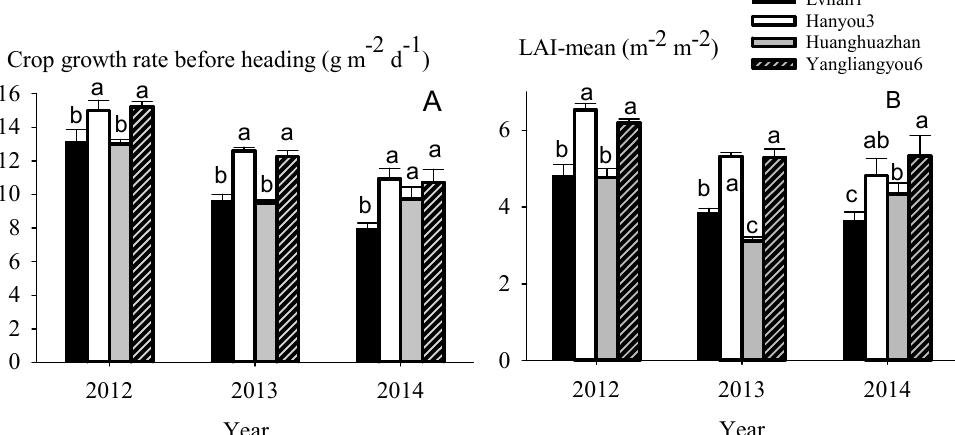
Figure 3. Crop growth rate (CGR) from sowing to heading ( A ) and mean leaf area index (LAI) from panicle initiation to heading ( B ). Lvhan1 (inbred) and Hanyou3 (hybrid) are typical upland rice cultivars. Huanghuazhan (inbred) and Yangliangyou6 (hybrid) are well-known lowland rice cultivars. Error bars represent SE. Different letters in each year means the significant differences at 0.05 level. Data were recorded based on the sampling area of 0.5 m 2 .